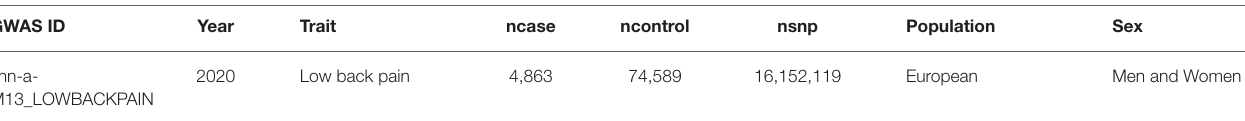
TABLE 2 | Genome-wide association study (GWAS) for low back pain.